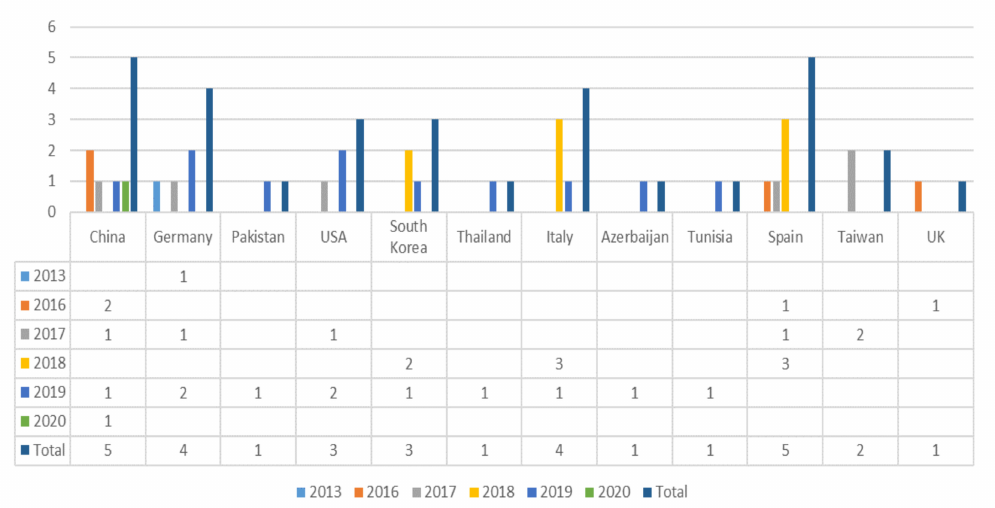
Figure 8. Geographic distribution of papers as a function of the publication year (source: